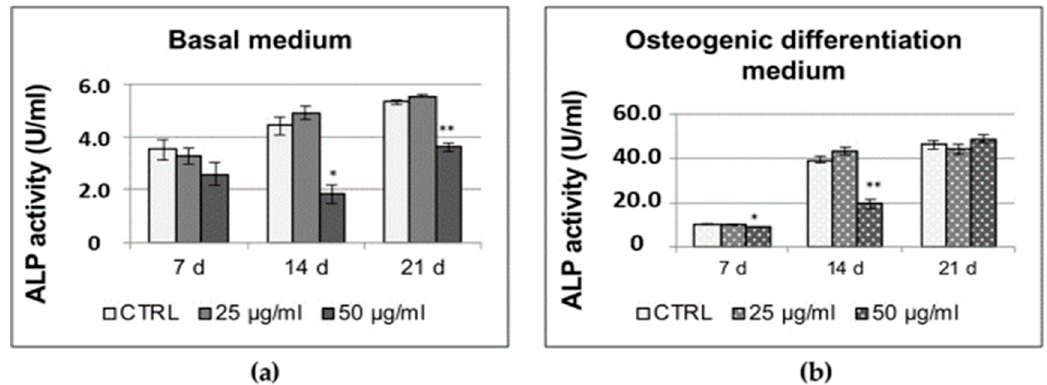
Figure 4. Alkaline phosphatase (ALP) activity assay. ( a ) ALP activity of control ADSCs and ADSCs treated with 25 μ g/mL or 50 μ g/mL of YB at 3, 7, 14 and 21 d of culturing in basal medium. ( b ) ALP activity of control ADSCs and ADSCs treated with 25 μ g/mL or 50 μ g/mL of YB at 3, 7, 14 and 21 d of culturing in osteogenic differentiation medium. * p < 0.05; ** p < 0.01 vs. CTRL.